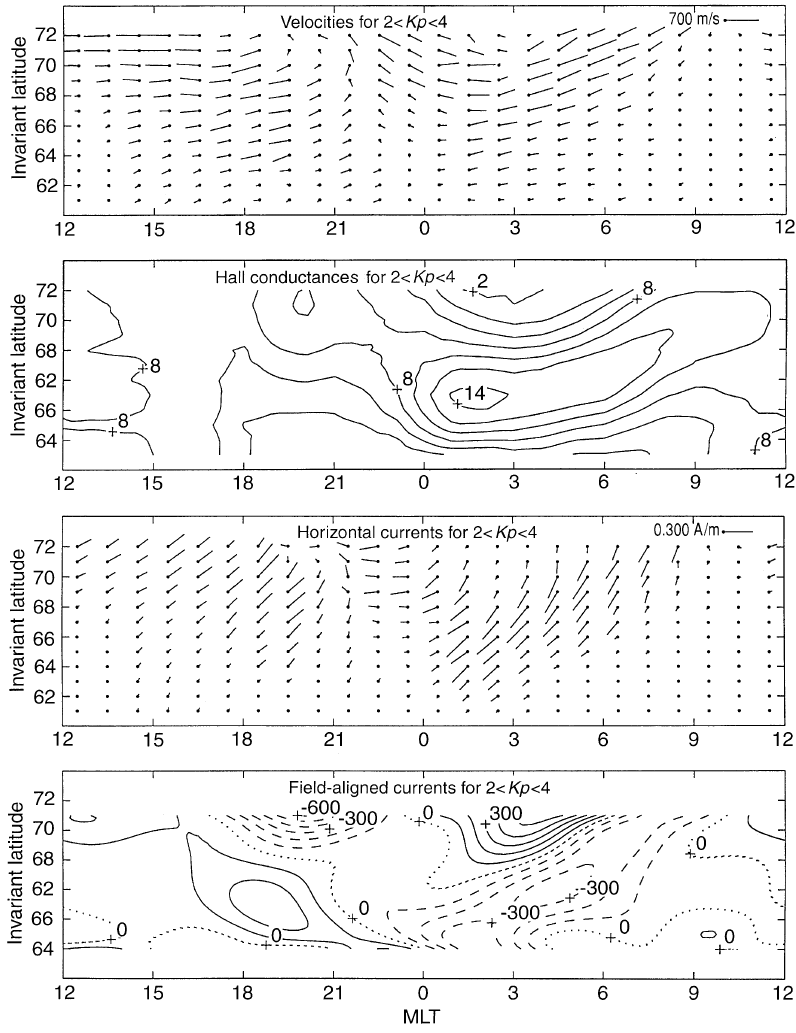
Fig. 6. Statistical distributions for Kp " 2 — 4 of convection velocities, Hall conductances (mhos), height-integrated horizontal currents, and field- aligned currents (downward currents with full lines , upward currents with dashed lines ); the cur- rent intensities are expressed in nA/m